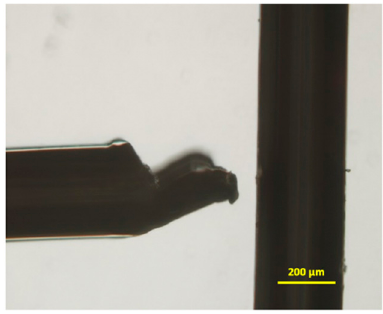
Figure 3. Sample image showing sealed platinum electrode setup for point and planar microwell with ≈ 75 μ m electrode spacing between them.